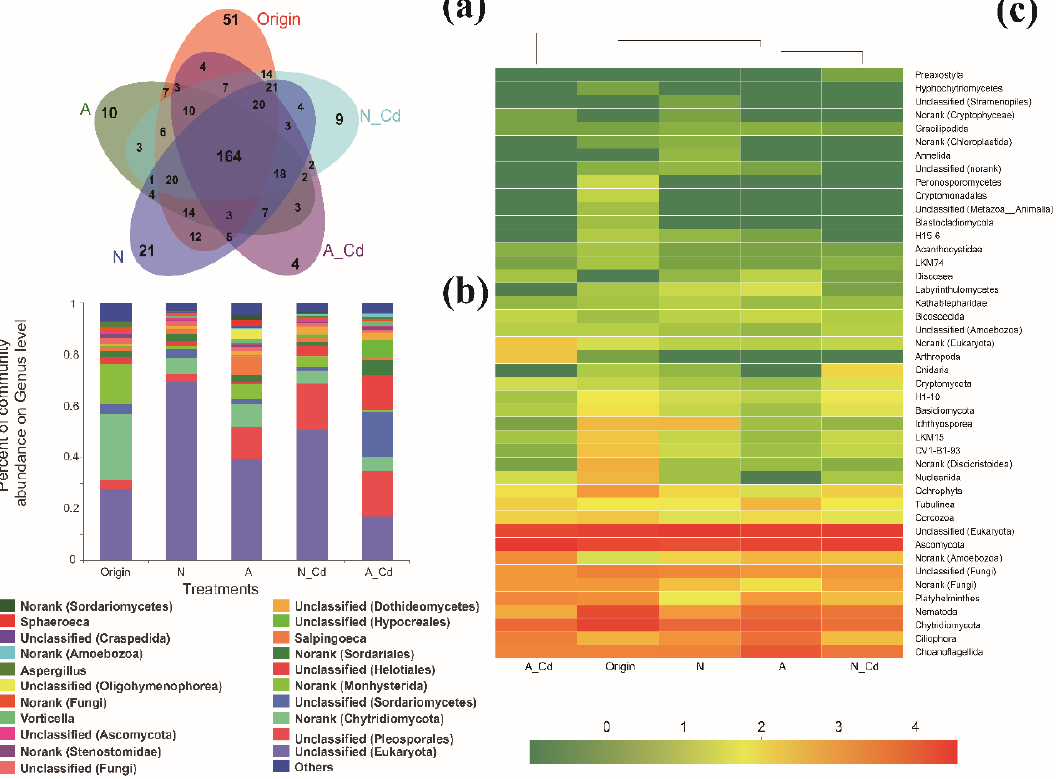
Figure 1. Fungal taxonomic composition by operational taxonomic units (OTUs) ( a ) and genus ( b ) levels and the most dominant 30 genera heat map diagram ( c ) among different treatments. N, natural light simulation group without cadmium; A/ALAN, simulation group without cadmium; N-Cd, natural light simulation group with cadmium; N-Cd, ALAN simulation group with cadmium.